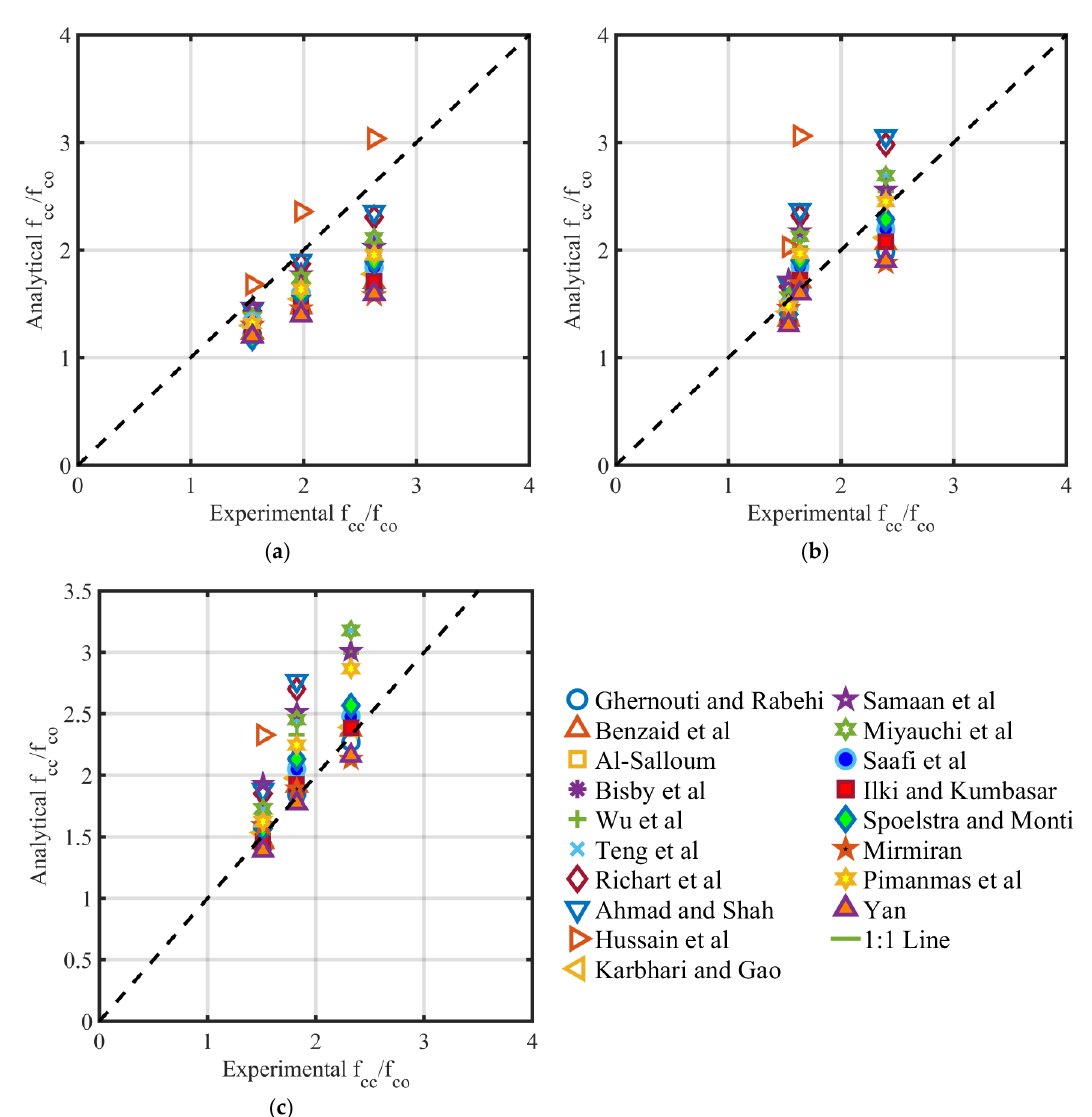
Figure 14. Comparison of analytical vs. experimental compressive strength of hemp FRRP confined cylinders ( a ) Group 1 ( b ) Group 2, and ( c ) Group 3.